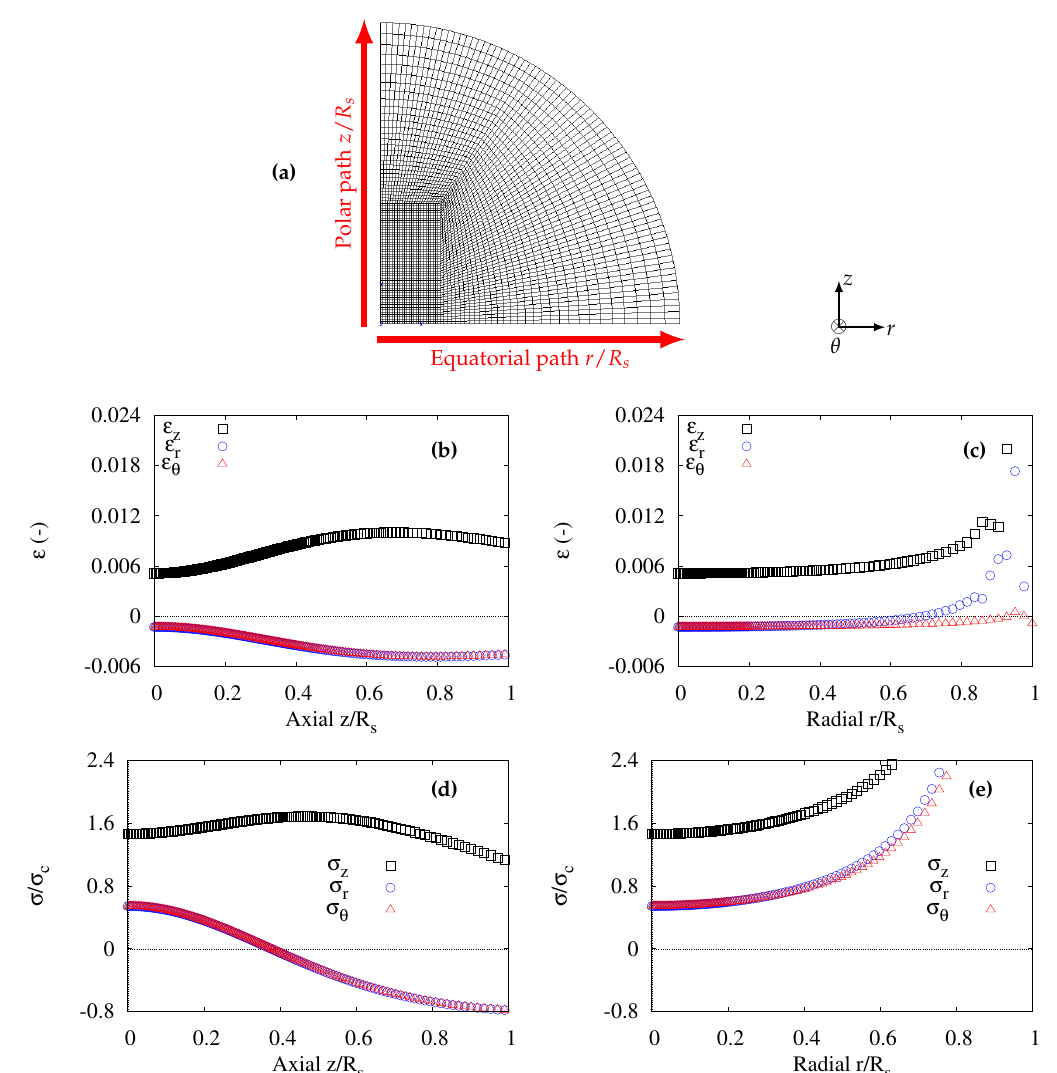
Figure 2. For an homogenized spherulite: ( a ) mesh and coordinates; ( b ) strains along the axial path; ( c ) strains along the radial path; ( d ) stresses along the axial path; ( e ) stresses along the radial